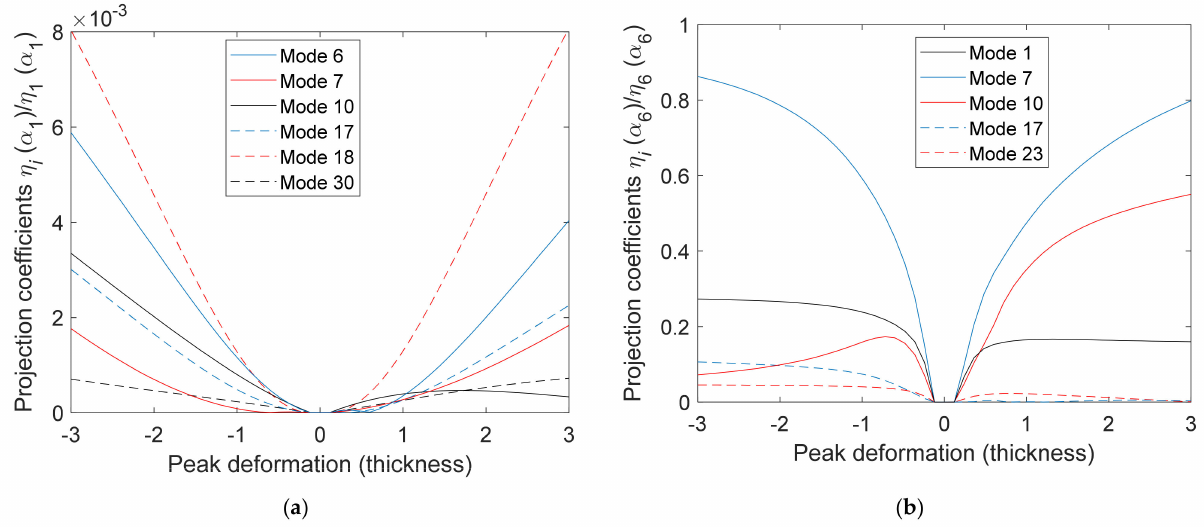
Figure 23. Normalized projection coefficients | η i ( α n ) / η n ( α n ) | of the static responses w n ( α n ) vs. load level α n , s for selected linear modes i , hat section of Figure 22. Mode ( a ) n = 1, ( b ) n =